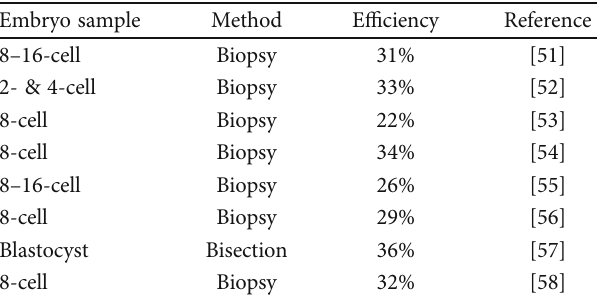
Table 3: Experiments in rhesus macaque embryo splitting. Embryo